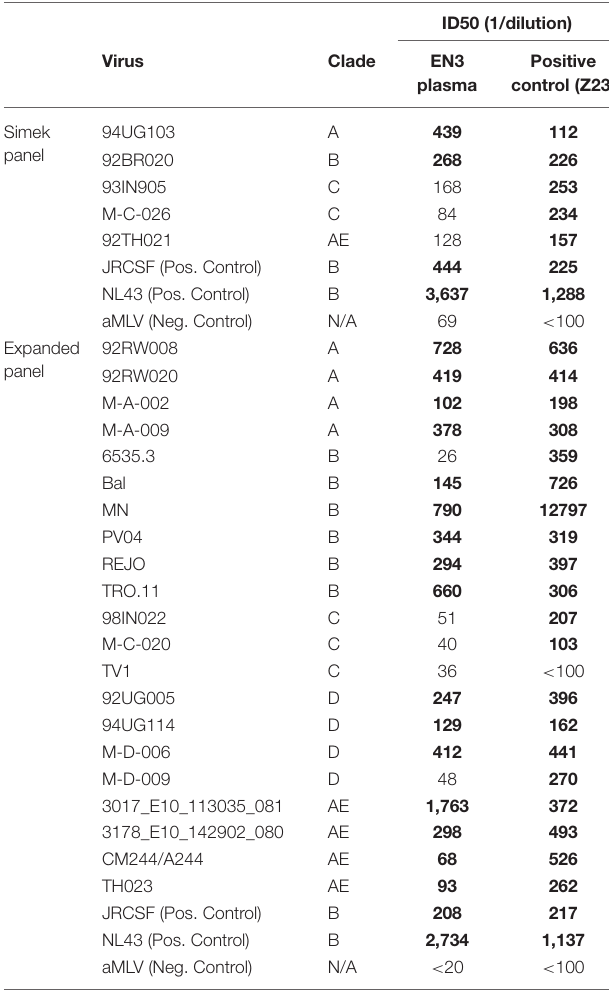
TABLE 1 | Expanded pseudovirus panel to define neutralization breadth in elite suppressor